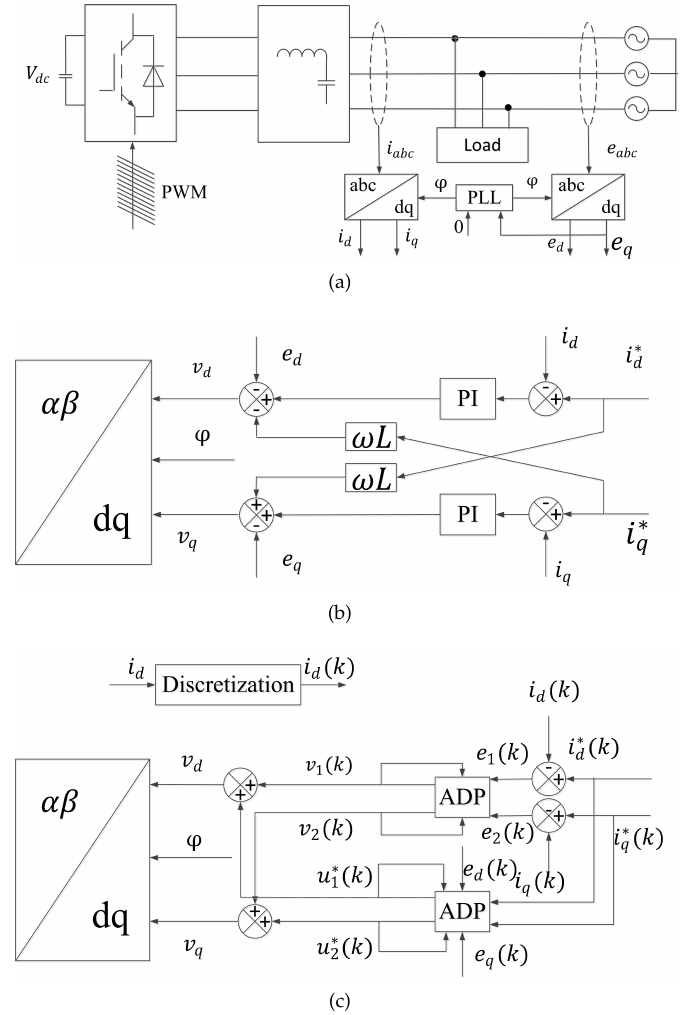
Figure 3. Inverter block diagram ( a ). PI closed-loop control block diagram ( b ). ADP closed-loop control block diagram ( c